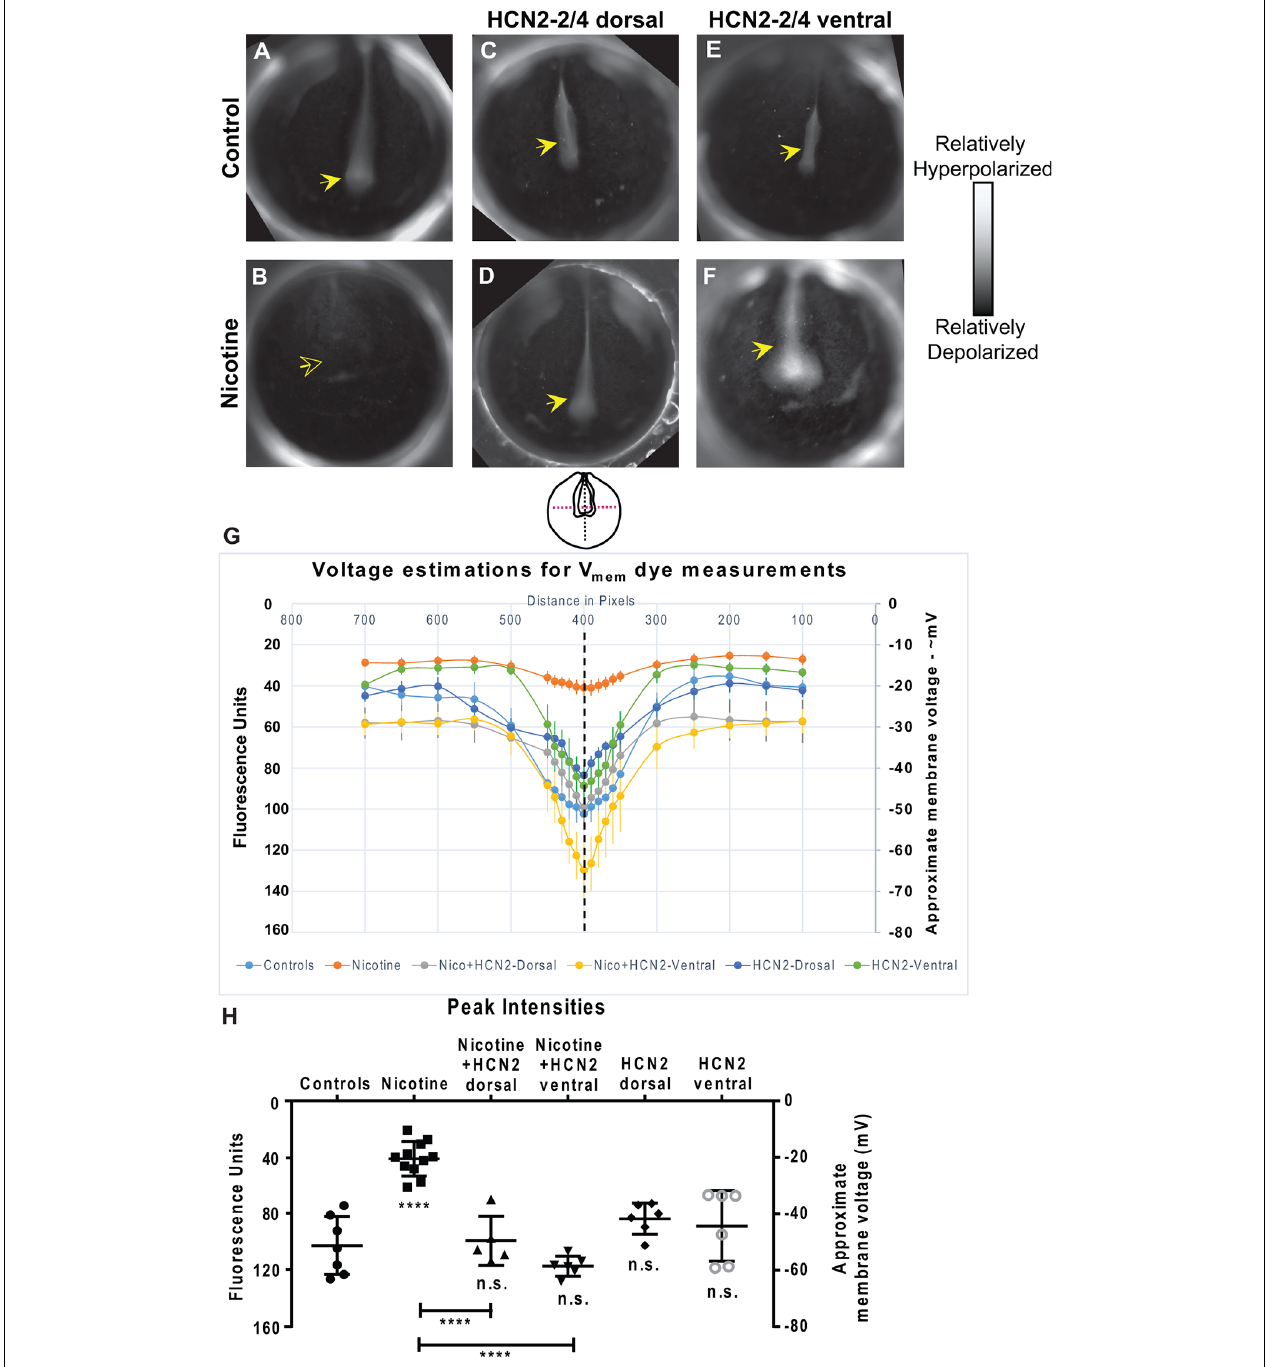
FIGURE 4 | Both local (CNS) and distant (non-CNS) expression of HCN2 channels restore neural developmental membrane voltage prepatterns in nicotine-exposed embryos. (A–F) Representative CC2-DMPE membrane voltage reporter dye images of stage ∼ 15 Xenopus embryos: Control (untreated and uninjected) or nicotine-treated embryos with or without microinjection with Hcn2-WT mRNA either in dorsal or ventral blastomeres at the four-cell stage. Solid yellow arrows indicate characteristic hyperpolarization in the neural plate as previously reported (Pai et al., 2015b, 2018). Hollow yellow arrows indicate significantly reduced signal (depolarization) within the neural plate in comparison to controls. (G,H) Quantification of fluorescence from CC2-DMPE images of stage 15 Xenopus embryos along with electrophysiology-based membrane voltage approximations [as previously reported in refs (Pai et al., 2015b, 2018)] for the indicated conditions. (G) Quantification obtained along the magenta dotted line indicated in the illustration. (H) Quantification at the point of intersection of the magenta and black dotted line indicated in the illustration. Data represented as mean ± SD, **** p < 0.0001. n.s.: non-significant (one-way ANOVA with Tukey’s post hoc test for N > 5 embryos for each treatment group at each point of the indicated spatial